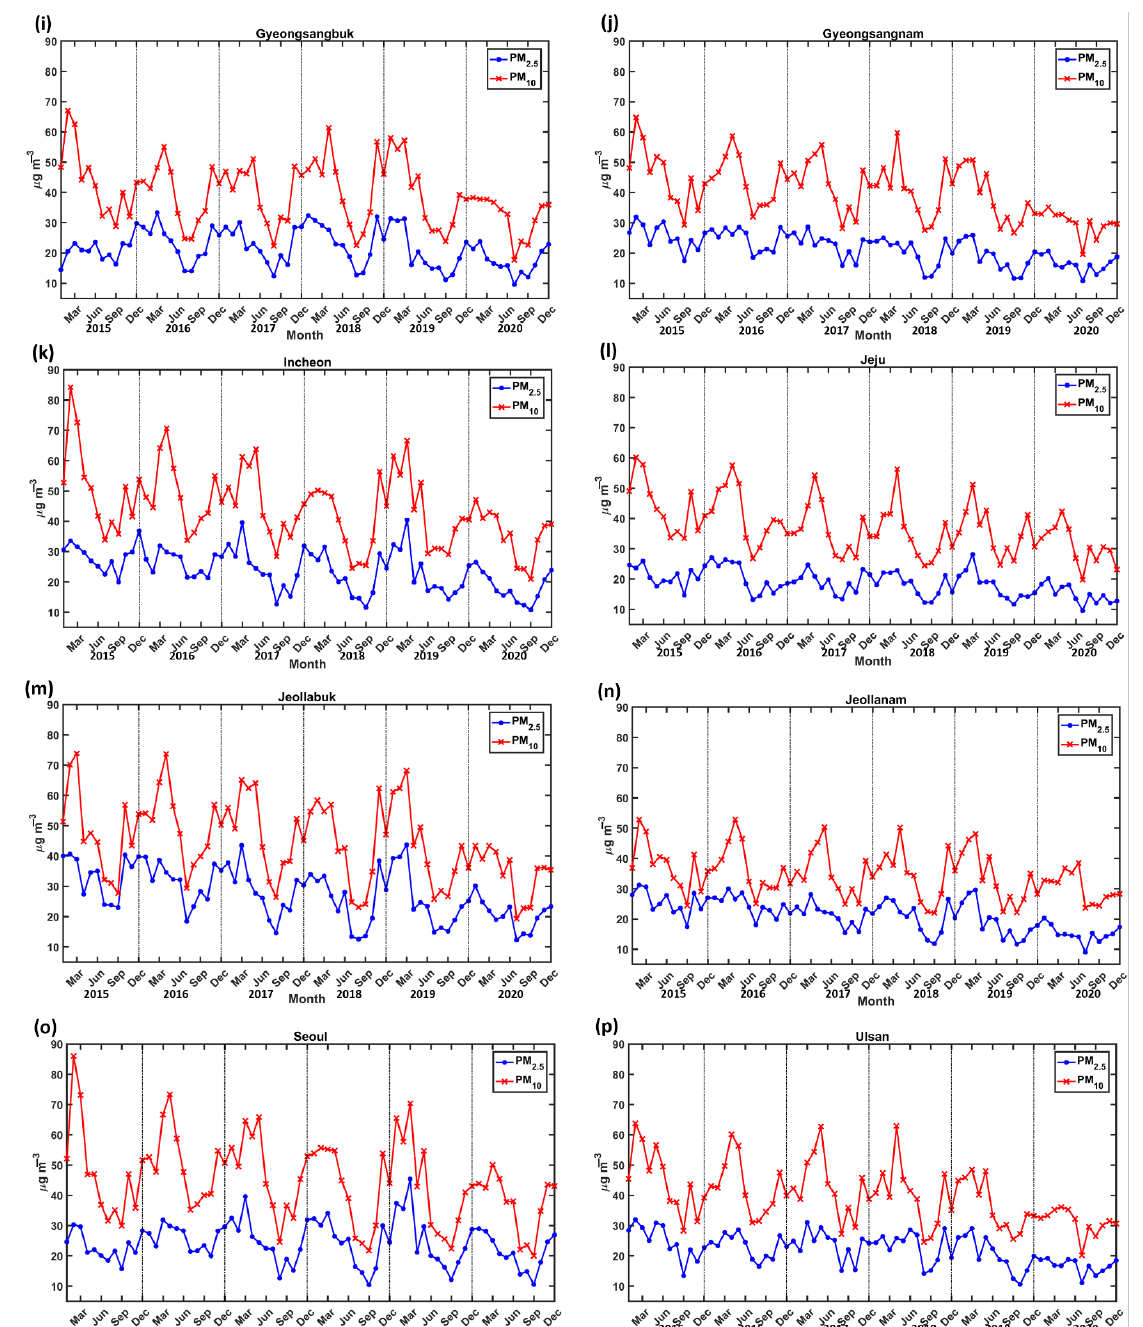
Figure 9. Monthly variations in PM 2.5 and PM 10 for the 16 administrative areas of South Korea from 2015 to 2020. ( a ) Busan, ( b ) Chungcheongbuk, ( c ) Chungcheognam, ( d ) Daegu, ( e ) Daejeon, ( f ) Gangwon, ( g ) Gwangju, ( h ) Gyeonggi, ( i ) Gyeongsanbuk, ( j ) Gyeongsangnam, ( k ) Incheon, ( l ) Jeju, ( m ) Jeollabu, ( n ) Jeollanam, ( o ) Seoul, and ( p )